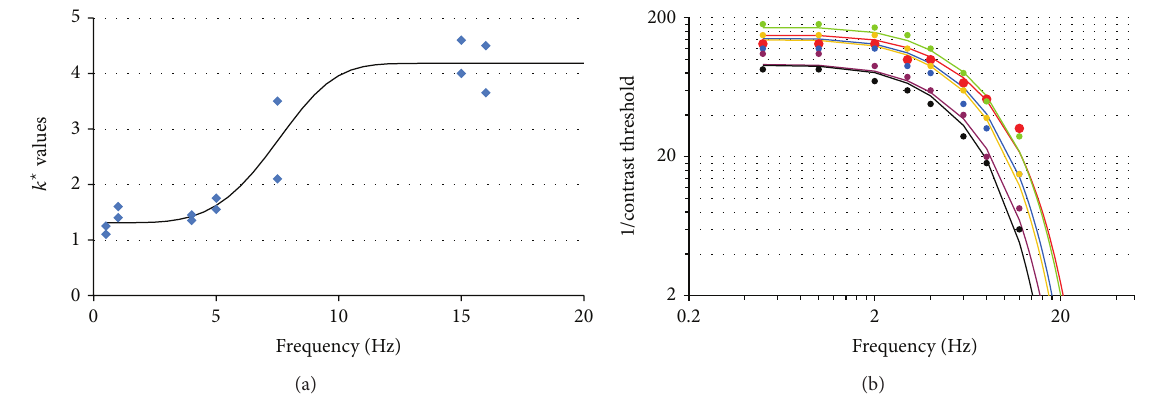
Figure 6: (a) Estimates of 𝑘 ⋆ as a function of the stimulus temporal frequency 𝑤 , from experimental CSF data from Elliott, Sloane, and Tulunay-Keesey [19, 21, 66]. (b) Example of the application of the proposed model to age-dependent spatiotemporal CSF from Tulunay- Keesey [66]. Red: 17 years; green: 25 years; blue: 34 years, yellow: 45 years; purple: 54 years; black: 62 years.